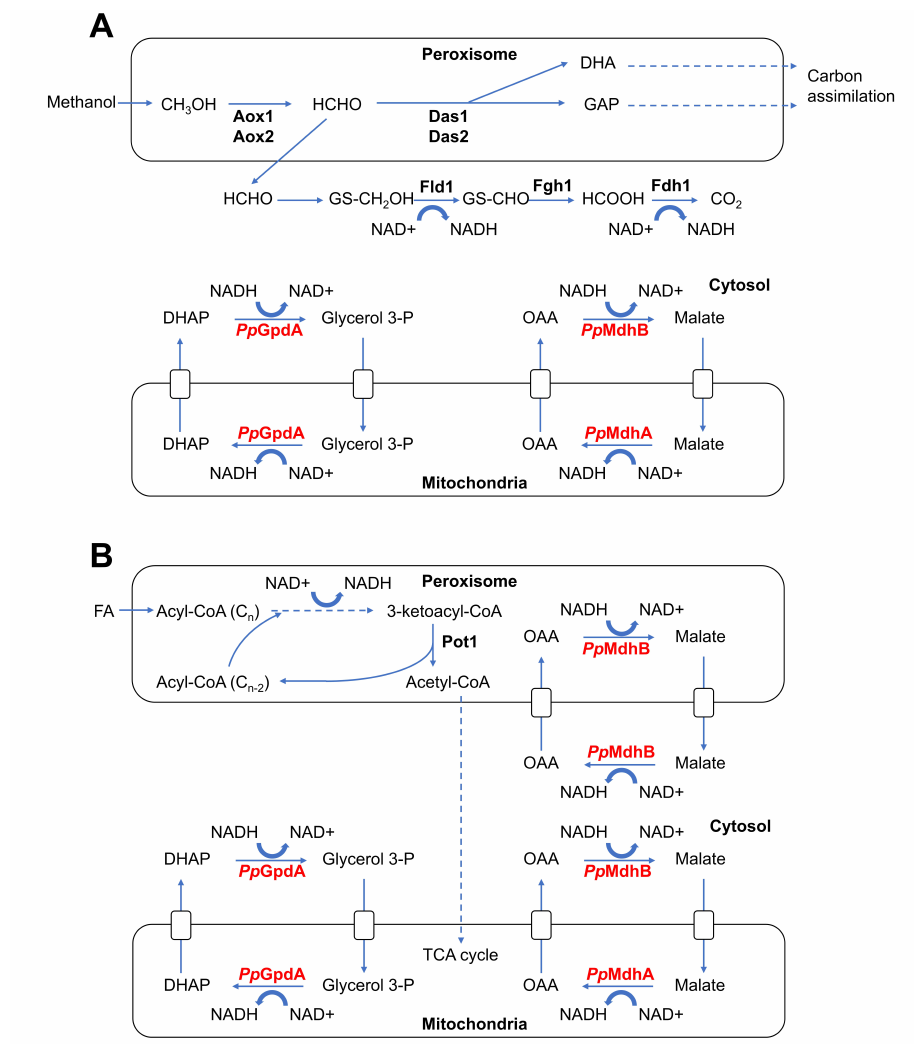
Figure 7. Proposed NADH shuttling in P. pastoris . ( A ) NADH shuttling in methanol. During methanol metabolism, methanol (CH 3 OH) is broken down into formaldehyde (HCHO), producing hydrogen peroxide (H 2 O 2 ) as a byproduct. Some formaldehyde is converted in peroxisomes into dihydroxyacetone (DHA), and glyceraldehyde-3-phosphate (GAP) by dihydroxyacetone synthase 1 and 2 (Das1 and Das2), for carbon assimilation. Some formaldehyde diffuses into the cytosol, producing NADH through reactions involving Fld1 (formaldehyde dehydrogenase) and Fdh1 (formate dehydrogenase). NADH produced in the cytosol from methanol metabolism may be shuttled to the mitochondria for energy production through the malate or glycerol 3-phosphate (glycerol 3-P) shuttles. MdhB can convert oxaloacetate into malate, oxidizing NADH into NAD + . Malate enters the mitochondria through a transporter. MdhA converts malate back to oxaloacetate, reducing NAD + to NADH. GpdA can convert dihydroxyacetone phosphate (DHAP) into Glycerol 3-P, oxidizing NADH into NAD + . Glycerol 3-P can shuttle into the mitochondria where GpdA can regenerate NADH. ( B ) NADH shuttling in oleate. Fatty acid (FA), is actively transported into peroxisomes and acetylated to acyl-CoA in an ATP-dependent reaction. The newly acylated fatty acid is then desaturated, consuming FAD + and producing H 2 O 2 as a byproduct. The newly formed, desaturated FA-CoA ester is hydrated, and then oxidized to form 3-ketoacyl-CoA and NADH. Finally, the 3-keto-acyl-CoA is cleaved by Pot1 (peroxisomal 3-oxyacyl-thiolase), releasing a molecule of acetyl-CoA and producing a fatty acyl-CoA, which is two carbons shorter than the substrate that entered the cycle. From this point, the product can restart the cycle. NADH produced in the peroxisomes during FA metabolism is shuttled out of the peroxisomes through the malate shuttle. MdhB converts oxalo-acetate into malate, regenerating NAD + . MdhB regenerates NADH in the cytosol and also shuttles NADH from the cytosol to the mitochondria. MdhB re-oxidizes NADH back to NAD + , reducing oxaloacetate to malate, which is transported into the mitochondria, where MdhA regenerates NADH in the mitochondria, converting malate back to oxaloacetate. The glycerol 3-P shuttle can also shuttle NADH from the cytosol to the